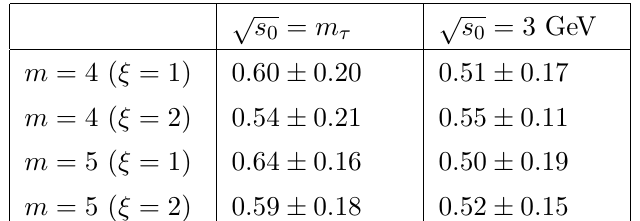
Table 2 . Results for the n f = 3 GC renormalon norm N g at orders m = 4 and 5 obtained from the optimal subtraction approach for s 0 = m 2 arise from varying the IR factorization scale in the range 0 . 7